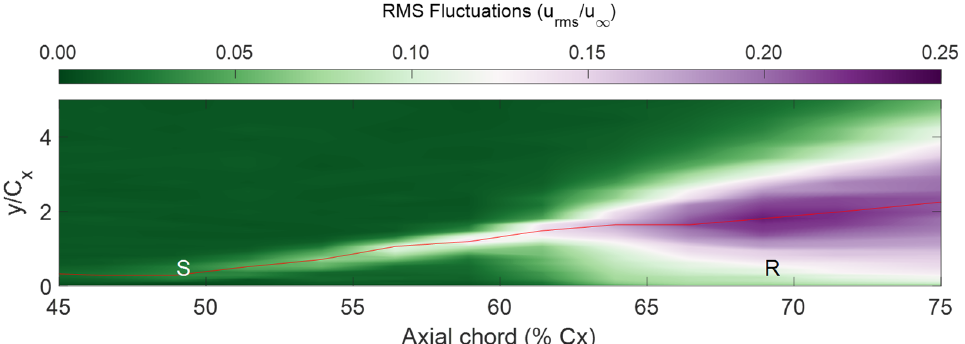
Figure 4. Contours of normalised 𝑢 (cid:3045)(cid:3040)(cid:3046) . The red line is the locus of maximum 𝑢 (cid:3045)(cid:3040)(cid:3046) intensity. S and R represent the approximate locations of flow separation and reattachment from the current measurements.